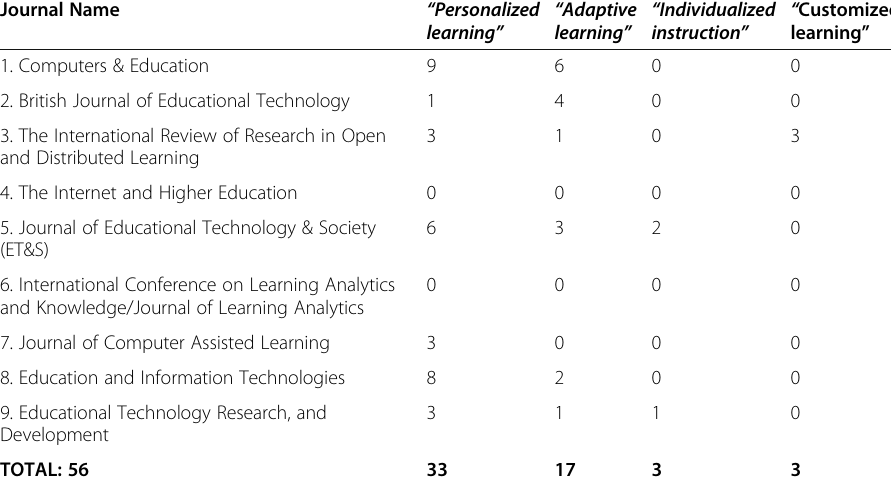
Table 4 Result-set size for the number of papers of “ personalized learning, ” “ adaptive learning, ” “ individualized instruction, ” and “ customized learning ” by the